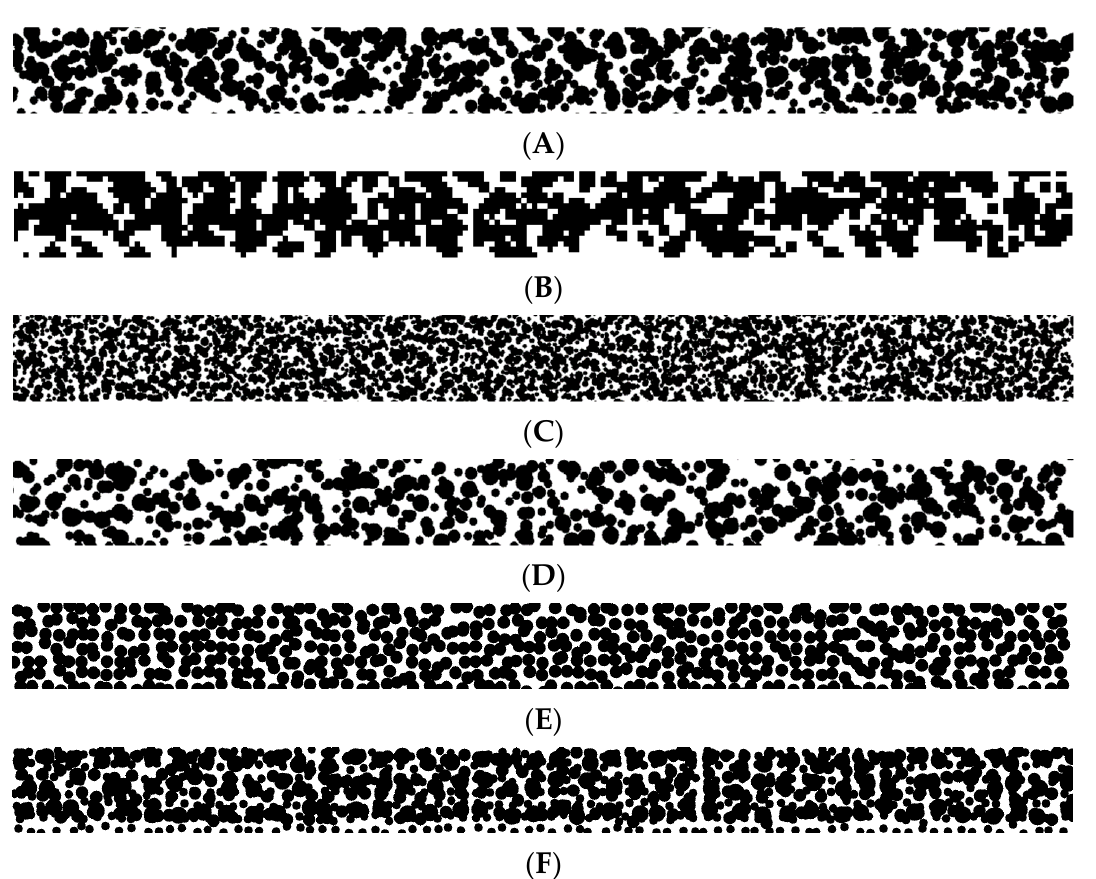
Figure 2. Examples of various RSPs: ( A ) RSP chosen as a source to be modeled in this work, ( B ) rescaled RSP for the purpose of FE model used in this work, ( C ) example of RSP generated for a smaller field of view, ( D ) example of RSP with higher sparsity, ( E ) example of RSP optimized for a particular scale, and ( F ) an example of RSP with lower influence of random speckle displacements.